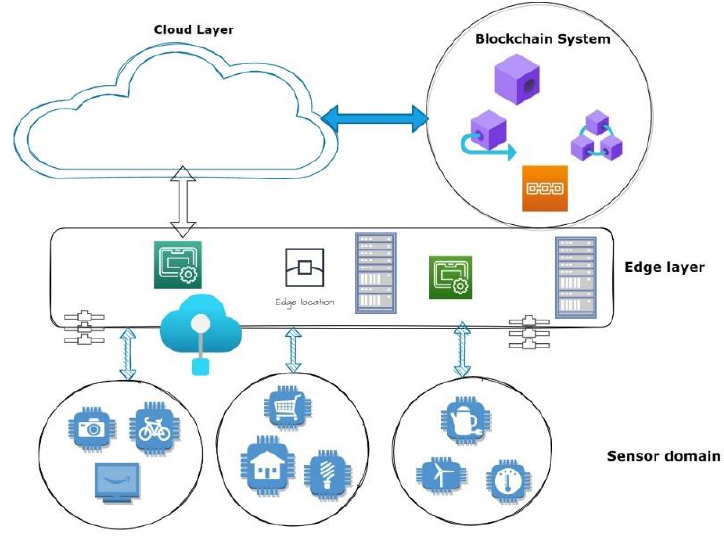
Figure 1. The proposed Blockchain-enabled IoT System’s architecture.